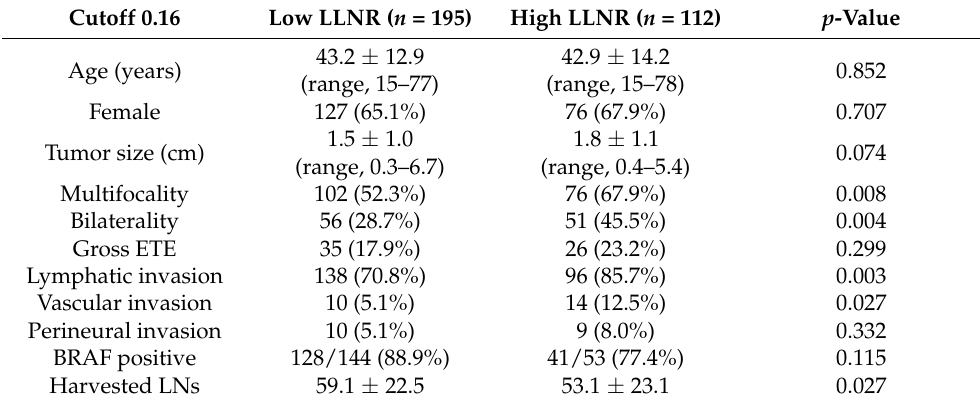
Table 3. Comparison of the baseline clinicopathological characteristics according to